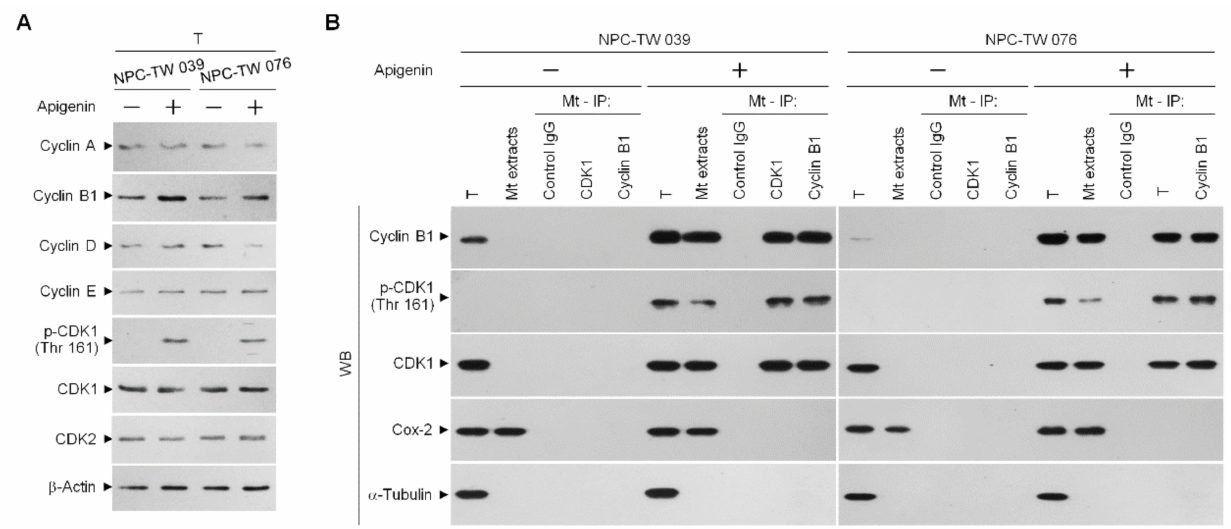
Figure 3. Induction of the formation of phospho (p)-cyclin dependent kinase 1 (CDK1) (Thr 161)–cyclin B1 complexes by apigenin. Nasopharyngeal carcinoma (NPC) cells were treated with vehicle ( − ) or apigenin (35 µ M) for 36 h. ( A ) The levels of the indicated proteins in the total cell (T) lysates were determined using Western blot analysis with specific antibodies. β -Actin was used as an internal control for sample loading. ( B ) The antibody used for coimmunoprecipitation is indicated at the top. The proteins from the immunoprecipitated complexes were detected using Western blotting with specific antibodies. Normal IgG was used as a control for antibody